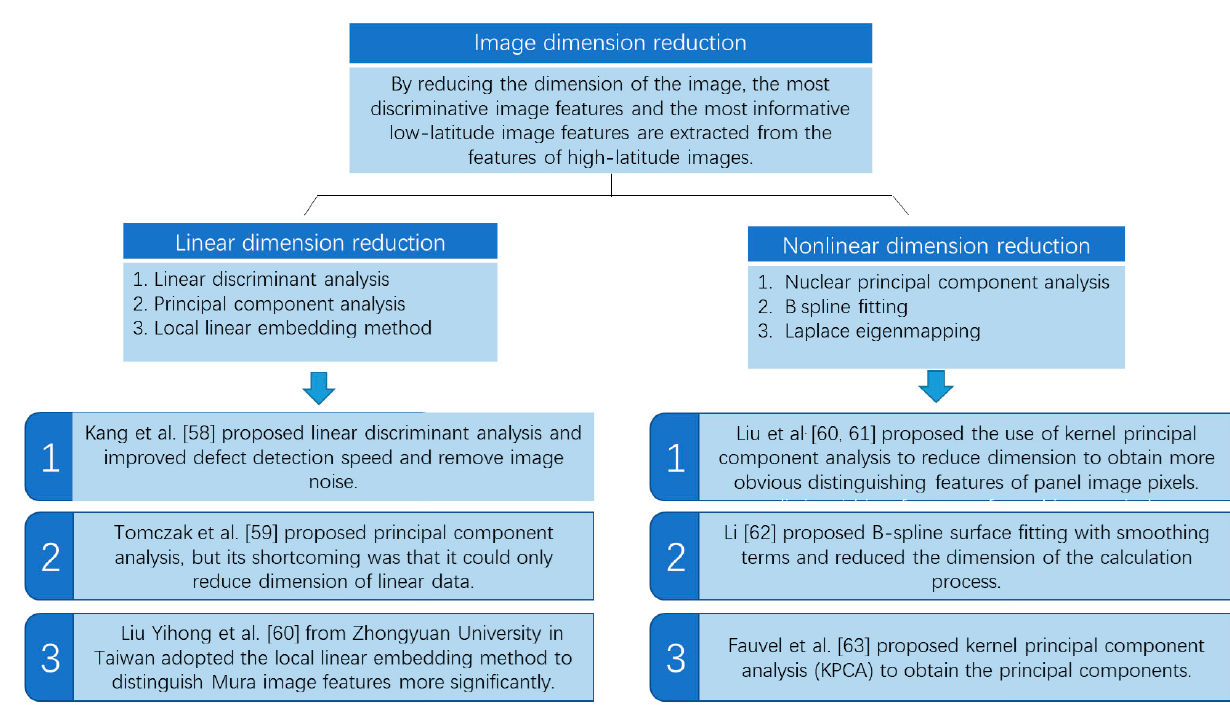
Figure 9. Comparative of linear dimension reduction and nonlinear dimension reduction.